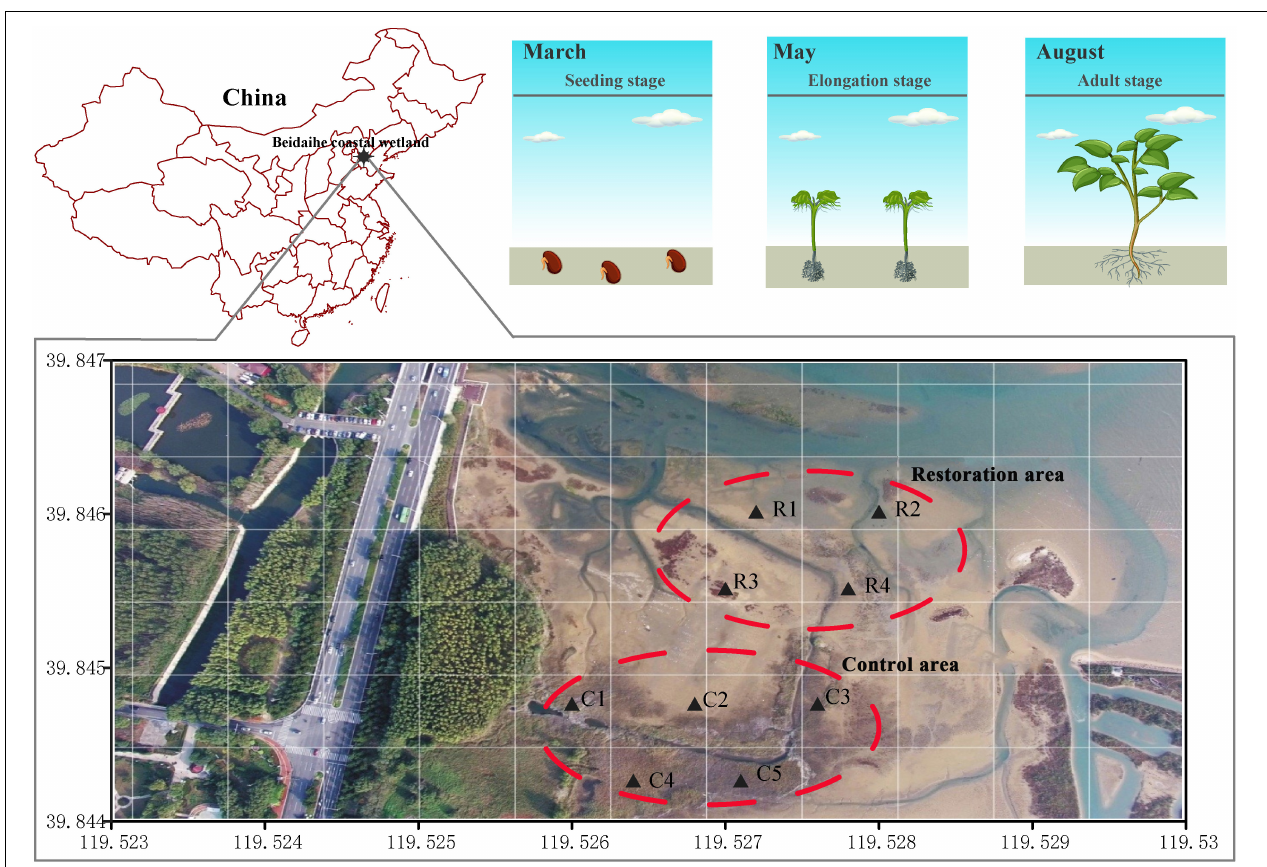
FIGURE 1 | Geographic location of sampling area in the Beidaihe coastal wetland. The aerial picture was taken in August 2016. Suaeda salsa barely grew in the restoration area and was dense in the control area. We sowed S. salsa seeds in March 2017 in the restoration area. The control area did not suffer degradation.